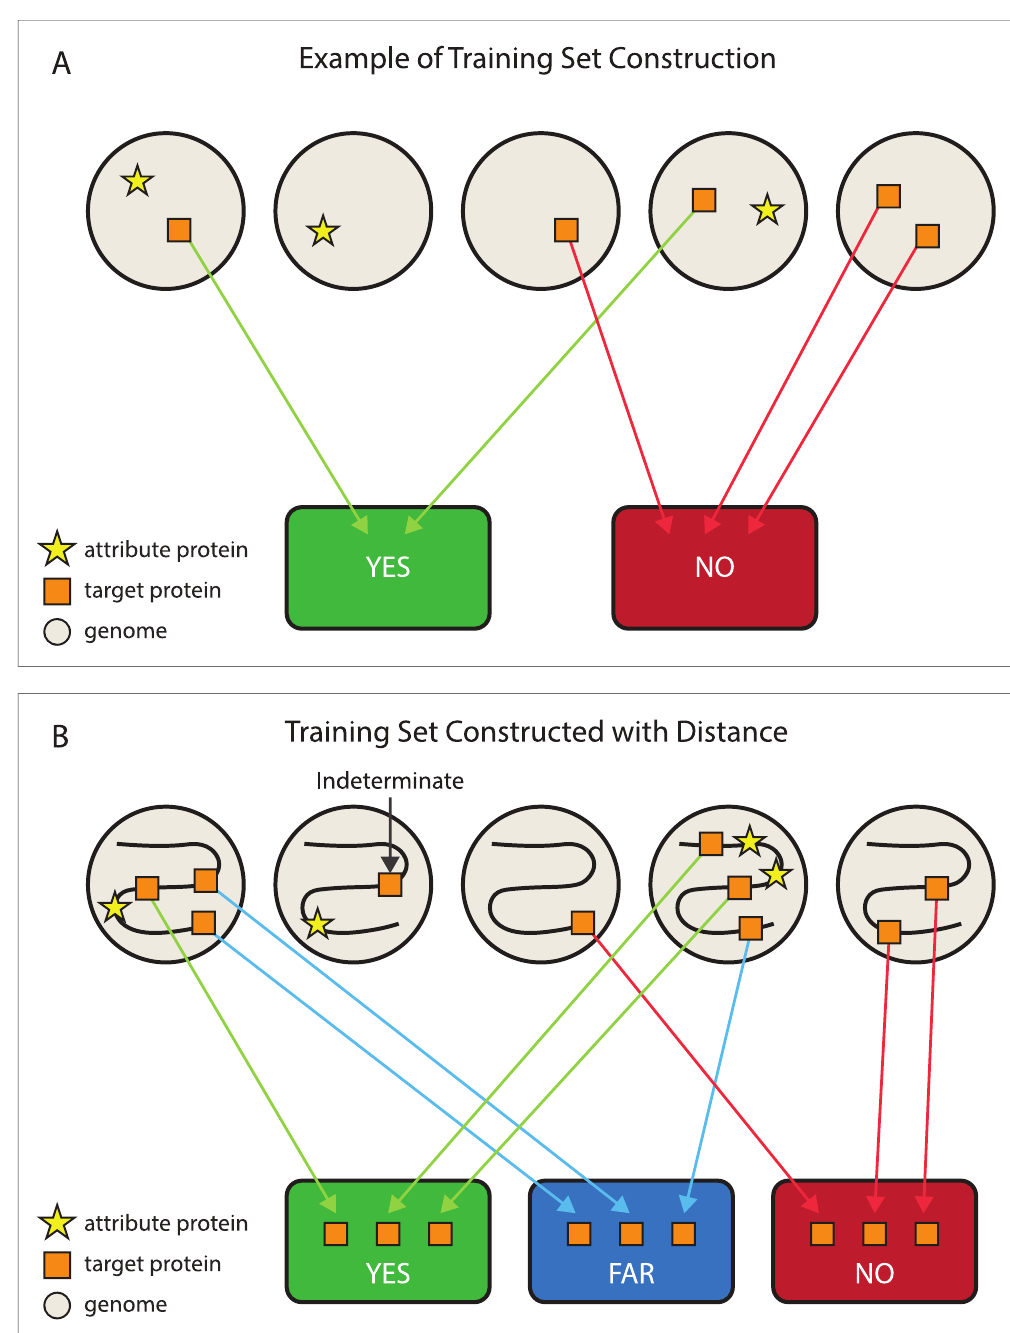
Fig 1. Training Set Construction. Fig 1A illustratesthe simplest method for trainingset construction. Each genome (gray circles) is treated as a “bag of genes”; distancerelationships betweengenes are ignored.One hiddenMarkov model (HMM) identifies target family proteins (orangesquares) in the corresponding proteome. A second HMM finds proteinsfrom a second family (yellow stars) whose presenceor absencein the proteome is the attribute that controls how target family proteins are sorted. If an attribute family protein is found, members of the target family get sorted to the YES set (green container). If not, then target family proteins go to the NO set (red container). The trainingset builder(TSB) always works on one target protein family at a time, but more complicatedrules may requiremultiple attributes to be jointly present for the YES set, and multiple attributes to be jointly absent for the NO set. Fig 1B shows trainingset constructionusing a distancerule. The S-shapedcurved represents a long segment of genomic DNA. A target protein is sorted to the YES set if and only if its gene lies within a user-specified distancefrom the attribute